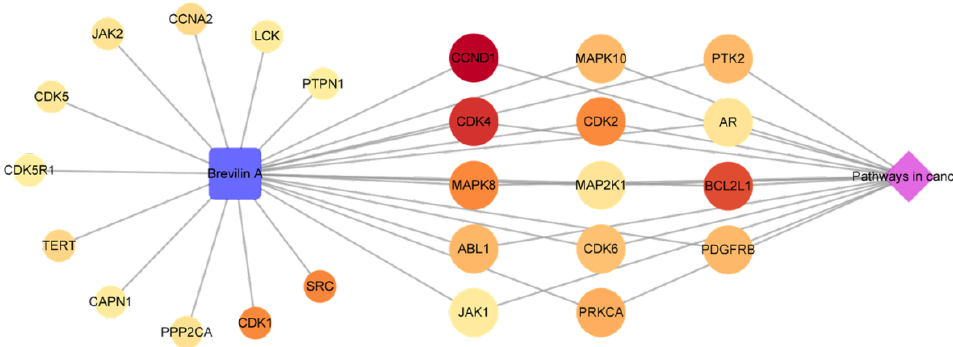
Figure 5. A compound-Key Target-Pathway network for the key targets of brevilin A.